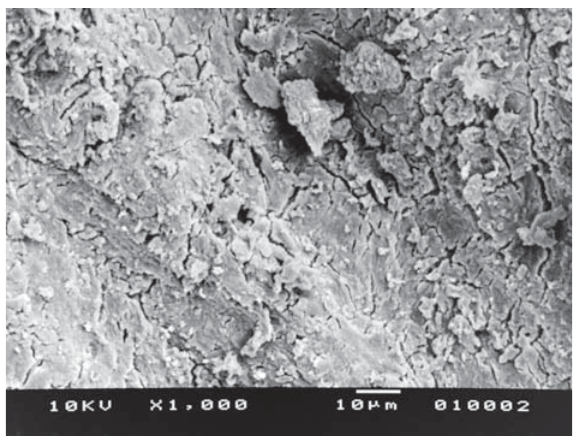
Figure 3- Scanning electron microscopy (SEM) micrograph of root dentin surface showing total closure of the dentinal tubule entrances by smear layer, corresponding to score (cid:29)(cid:11)=(cid:27)(cid:10)(cid:10)(cid:6)?(cid:11)=G(cid:29)(cid:28)(cid:31)(cid:31)(cid:31)(cid:11)(cid:8)(cid:5)(cid:20)(cid:9)(cid:16)#(cid:17)(cid:5)(cid:7)(cid:16)(cid:10)(cid:9)?